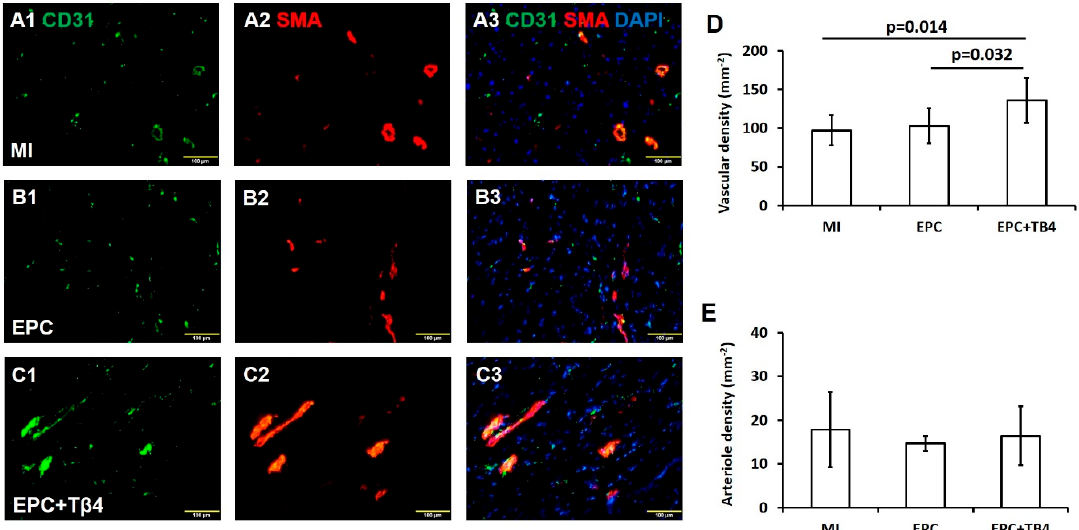
Figure 4. Fluorescence immunostaining for CD31 + ( A1 , B1 , and C1) and smooth muscle actin (SMA) ( A2, B2, and C2 ) expressions in hearts of MI, EPC, and EPC + T β 4 rat groups. ( A3 ) Overlay images of A1 and A2. ( B3 ) Overlay images of B1 and B2. ( C3 ) Overlay images of C1 and C2. Quantification of total vascular density based on CD31 + expression ( D ) and arteriole density based on co-localization of CD31 + and SMA ( E ) (A–C magnification = 200×) ( n = 6 for each group).